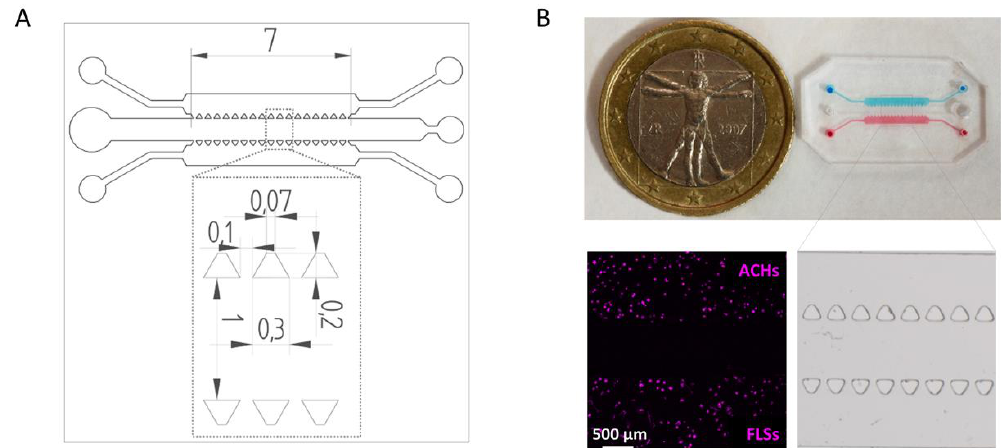
Figure 1. Design and fabrication of the microfluidic device. ( A ) Technical drawing of the microfluidic device with dimensions of trapezoidal posts and channels expressed in mm. ( B ) Top-view of the microfluidic device with ACH (blue) and FLS (red) compartments. The inset shows a stereomicroscope image of the microfluidic chip features. Representative picture showing ACHs and FLSs embedded in fibrin gels after